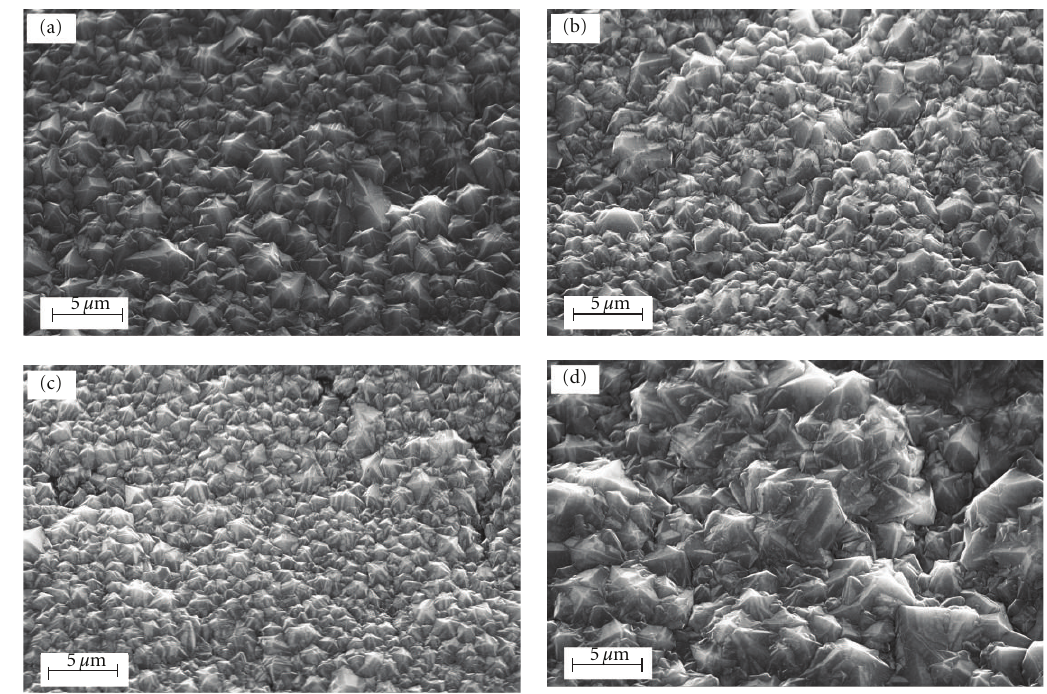
Figure 3: Diamond films after 8h HF-CVD (a), PF 16 (b), PF 8 (c), and PF 3 (d) MPS.